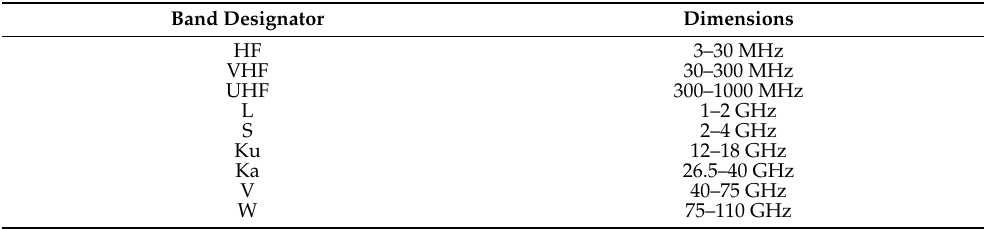
Table 3. IEEE standard letter designations for different frequency bands